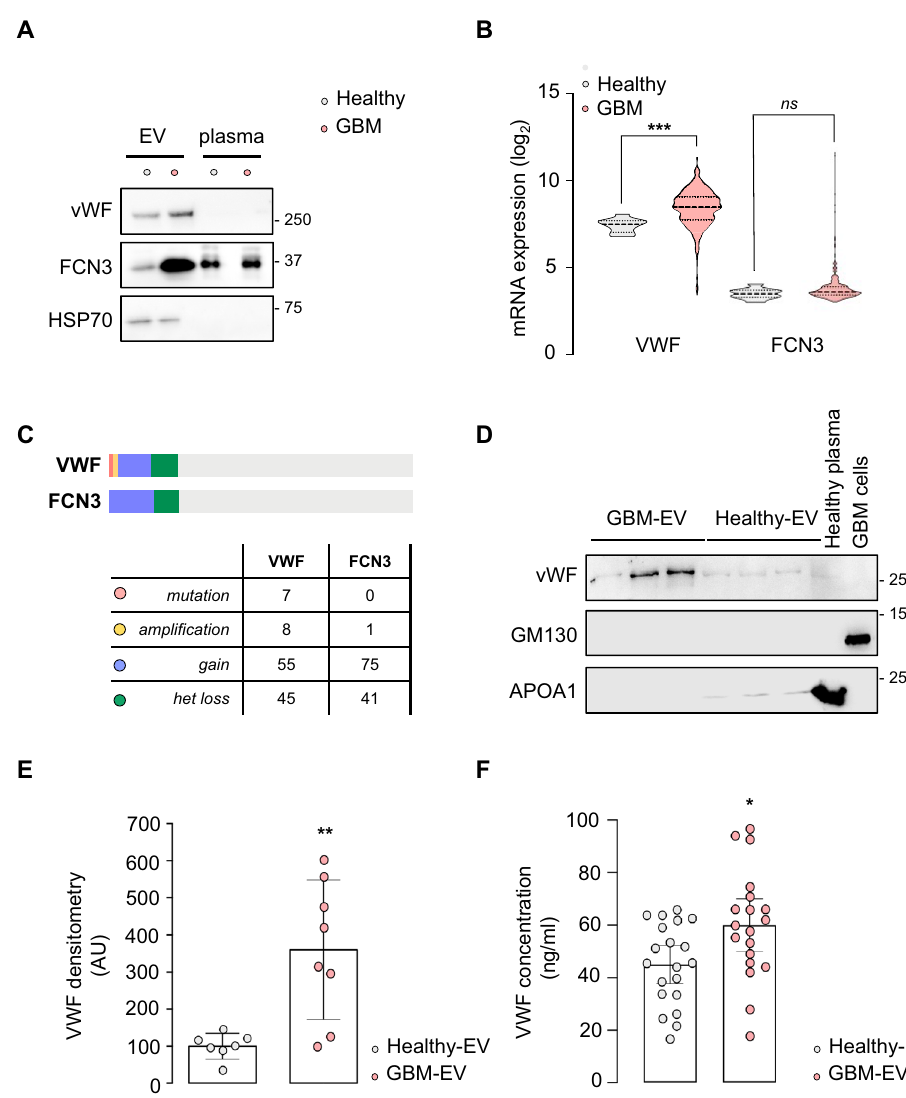
Figure 4. VWF is transported in circulating EVs from GBM patients. ( A ) Equal volume of protein lysates from EV fractions, obtained with SEC followed by ultracentrifugation, and their corresponding plasma, from one GBM patient and one healthy donor, were separated by SDS-PAGE and analyzed by immunoblot for VWF, FCN3, and HSP70. Blots are representative of n = 3. ( B ) mRNA expression of von Willebrand factor (VWF) and ficolin-3 (FCN3) in healthy subjects and GBM patients estimated from The Cancer Genome Atlas (TCGA, n > 500 for GBM patients). ( C ) Anomalies currently reported in VWF and FCN3 genes. ( D ) Equal volume of protein lysates from EV fractions (3 GBM and 3 Healthy) were separated by SDS-PAGE and analyzed by immunoblot for VWF, GM130 (putative intracellular membrane protein contaminant), and Apolipoprotein A1 (APOA1, plasmatic protein). Healthy donor plasma and total cell lysate from GBM cells serve as controls. Blots are representative of n > 7 individual samples. ( E ) Densitometric analysis was performed on 7 and 8 independent EV preparations from Healthy and GBM liquid biopsies, respectively. ( F ) Concentration of VWF in plasmatic EVs from healthy donors and GBM patients (n = 20). Mann–Whitney test, * p < 0.05, ** p < 0.01, *** p < 0.001. S.D. are shown in panel E and S.E.M. in panel